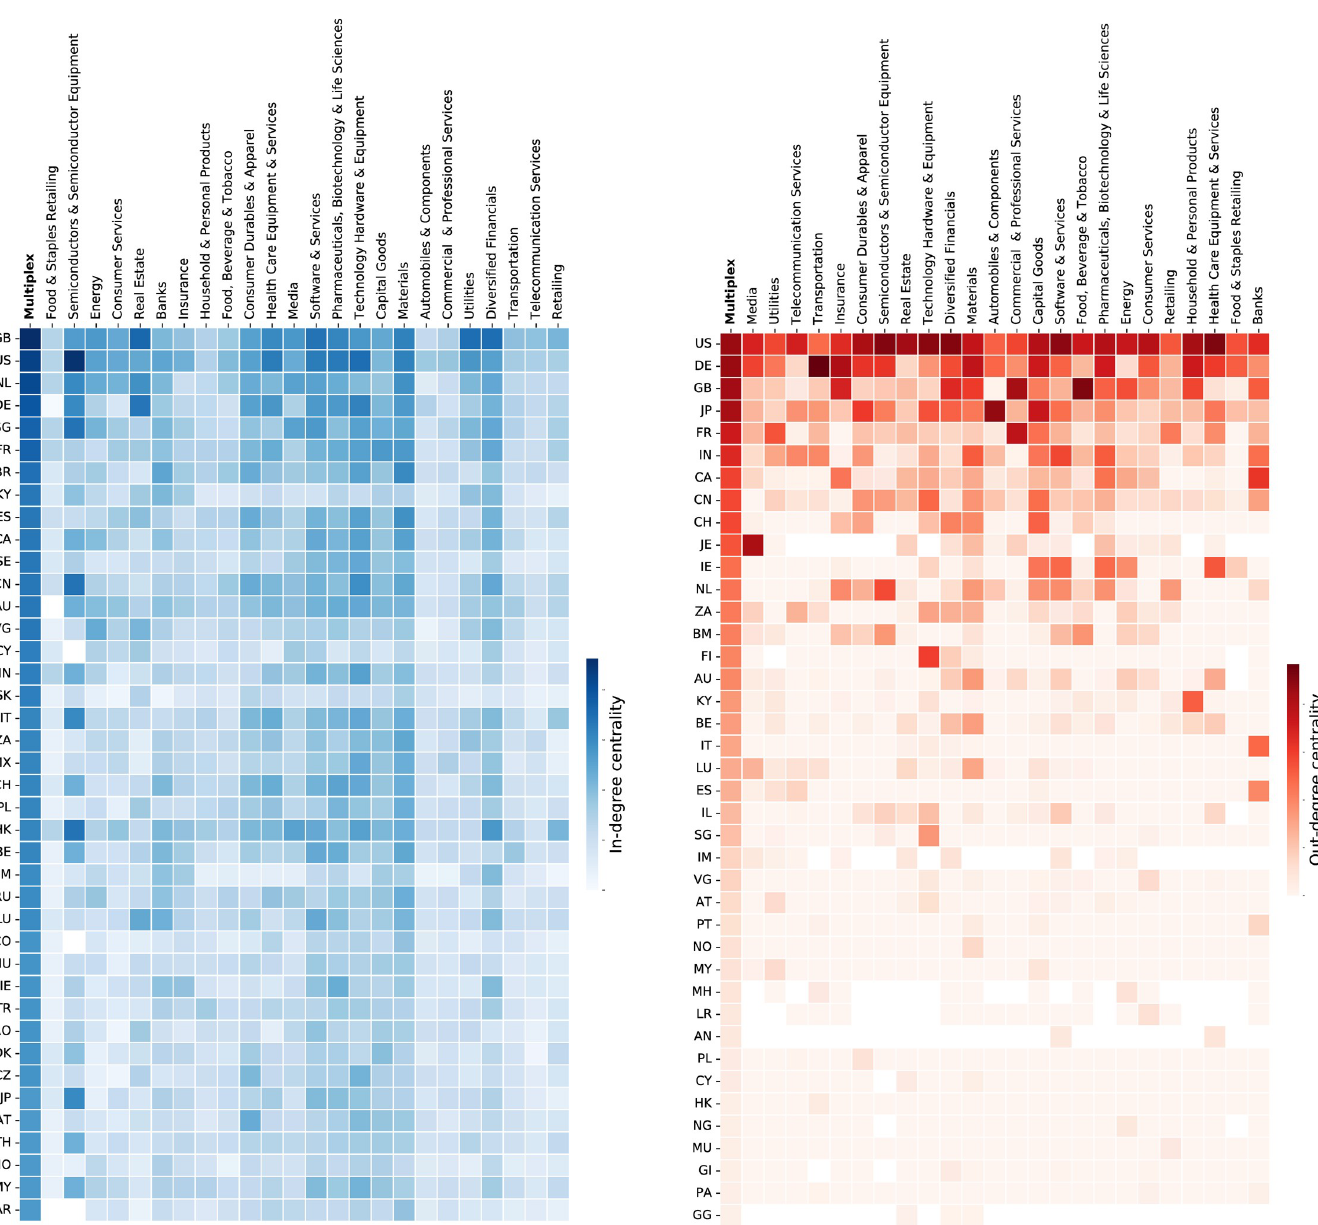
PLOS ONE | https://doi.org/10.1371/journal.pone.0255450 August 16,